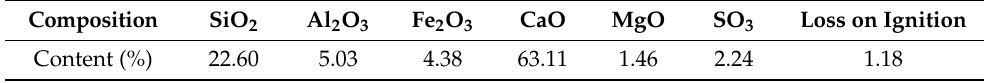
Table 1. Chemical composition of the cement.